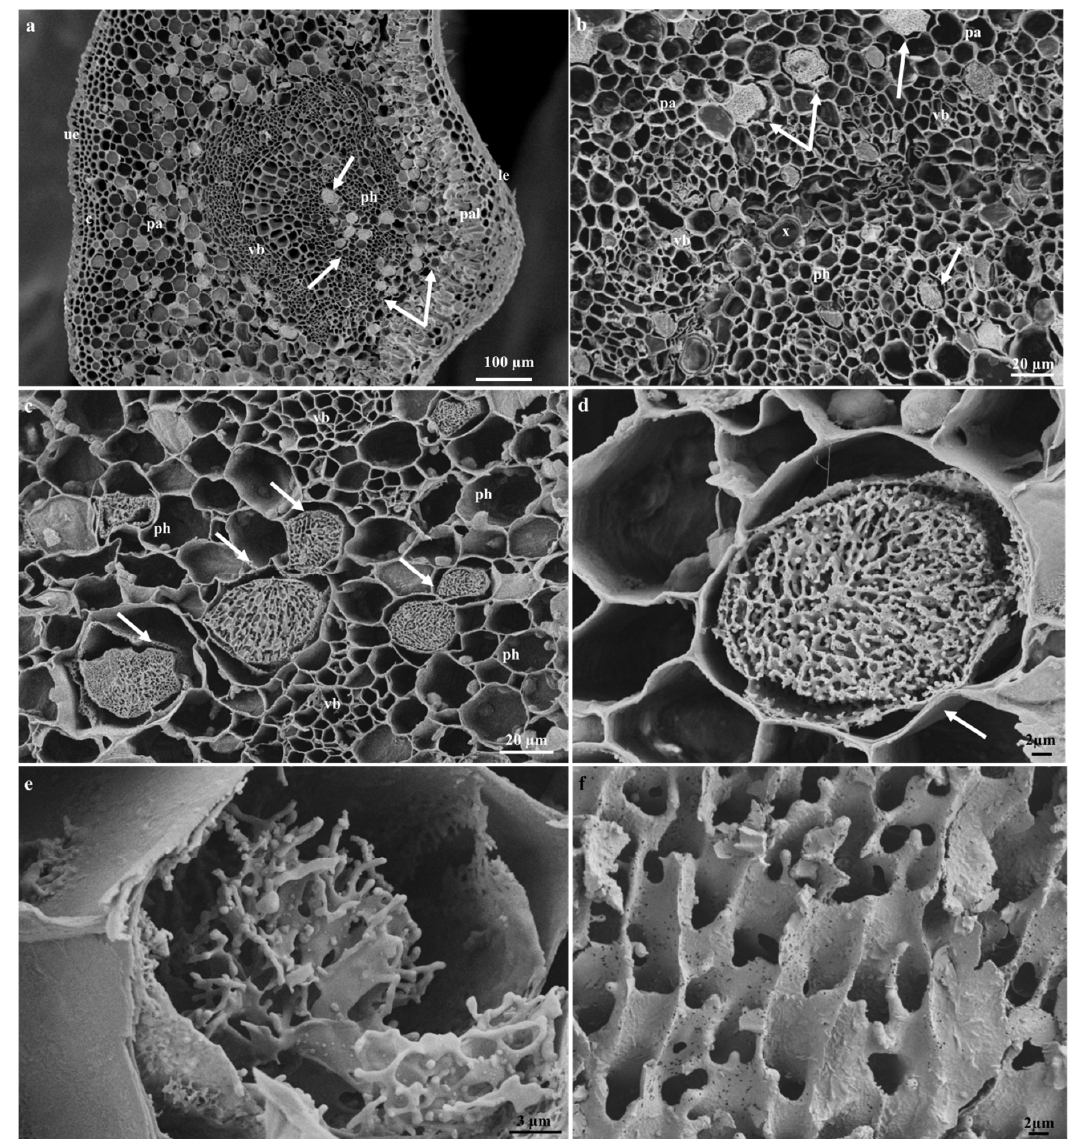
Figure 5. Scanning electron microscopy micrographs showing freeze-fractures of the adult leaves of T. ventricosa . ( a ) Low-magnification SEM micrograph showing a freeze-fracture of the midrib from a young leaf. ( b ) Freeze-fracture showing the distribution of laticiferous cells along the vascular bundles and phloem of a mature leaf midrib. ( c ) Laticifer cell distribution among vascular bundles of a young leaf midrib. ( d ) Laticifer cell showing latex exudate from a young leaf. ( e ) Latex exudate within laticifer cell from a young leaf. ( f ) High-magnification image showing the appearance of latex exudate from an emergent leaf. Abbreviations: ue = upper epidermis, c = collenchyma, pa = parenchyma, vb = vascular bundles, ph = phloem, x = xylem, pal = palisade, le = lower epidermis. Arrows refer to laticifer.